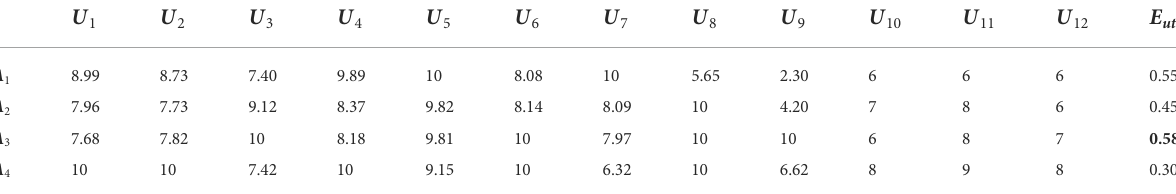
TABLE 4 Scoring results of each excavation scheme in this case.